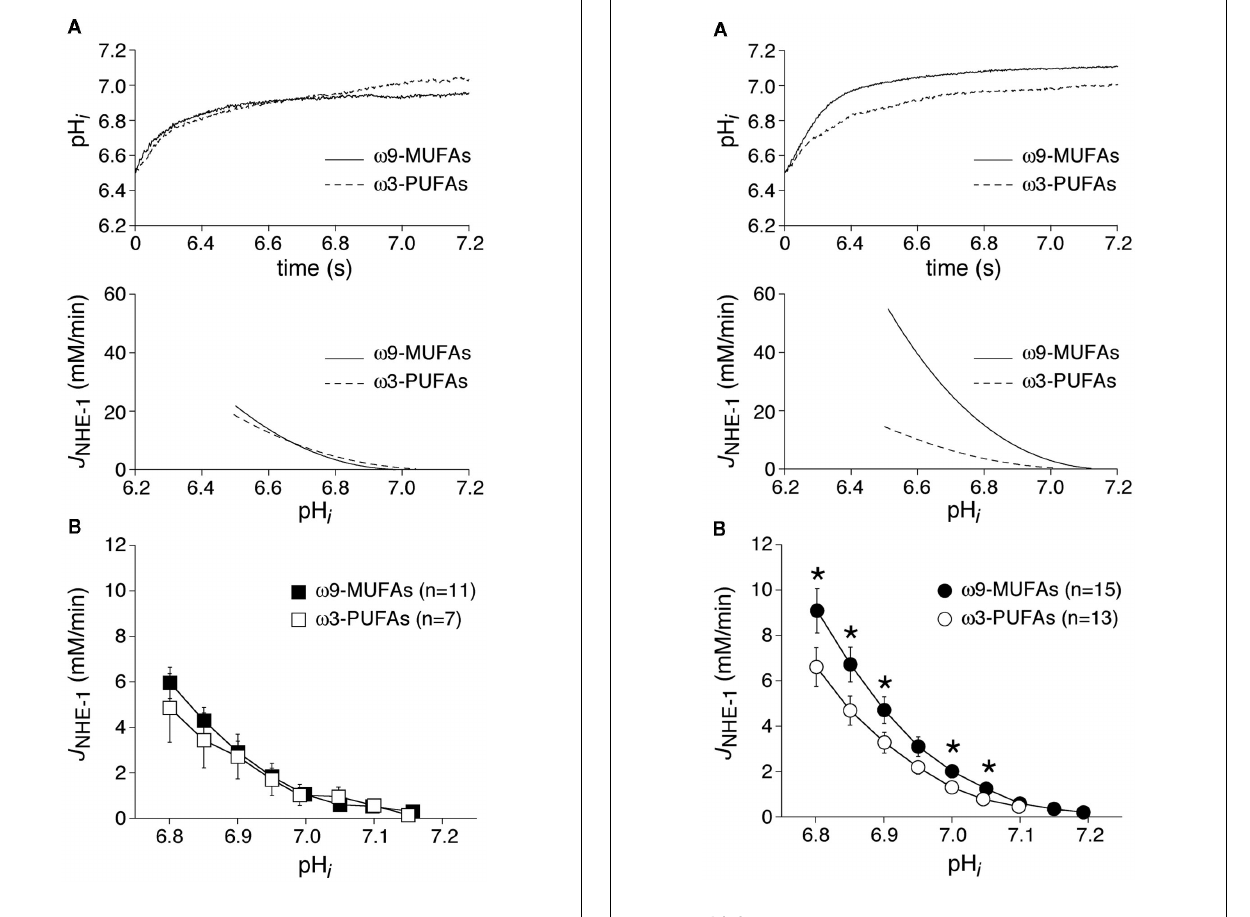
FIGURE 2 | (A) Typical examples of pH i recovery after an ammonium prepulse (top) and the calculated J NHE-1 (bottom) in an ω 9-MUFA and ω 3-PUFA myocyte isolated from healthy animals. (B) Average J myocytes of ω 9-MUFA and ω 3-PUFA fed healthy animals.